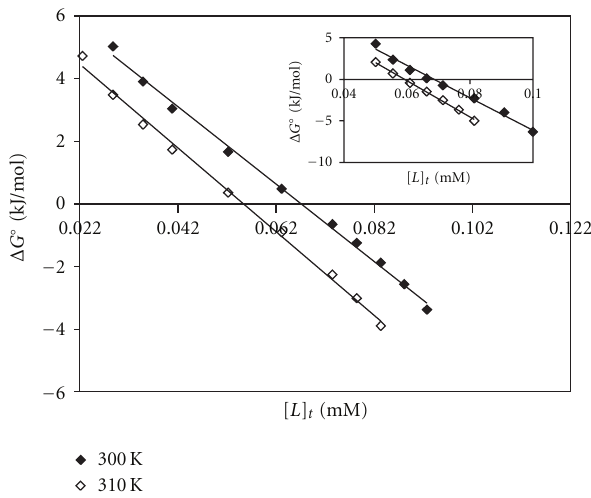
Figure 3: The molar Gibbs free energies of unfolding ( Δ G ◦ versus [ L ] t ) of CT-DNA in the presence of [Pt(bpy)(Oct-dtc)]NO 3 and the inset for [Pd(bpy)(Oct-dtc)]NO 3 .